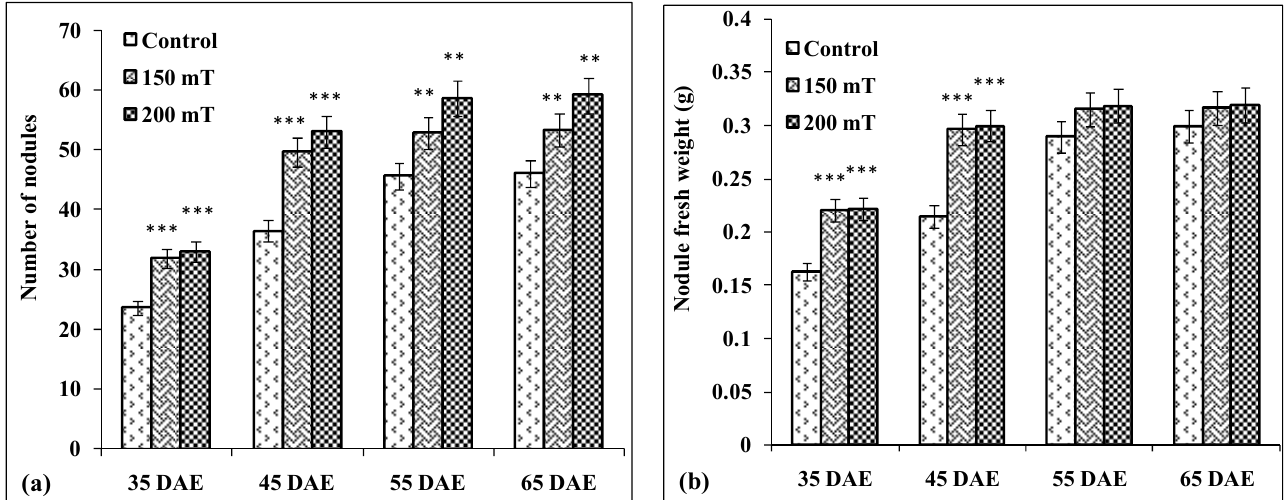
Figure 15. Effect of pre-sowing exposure of soybean seeds to magnetic field on number of nodules ( a ), and nodules fresh weight ( b ). *** and ** indicate significance at p < 0.001 and 0.01, respectively, compared to control.